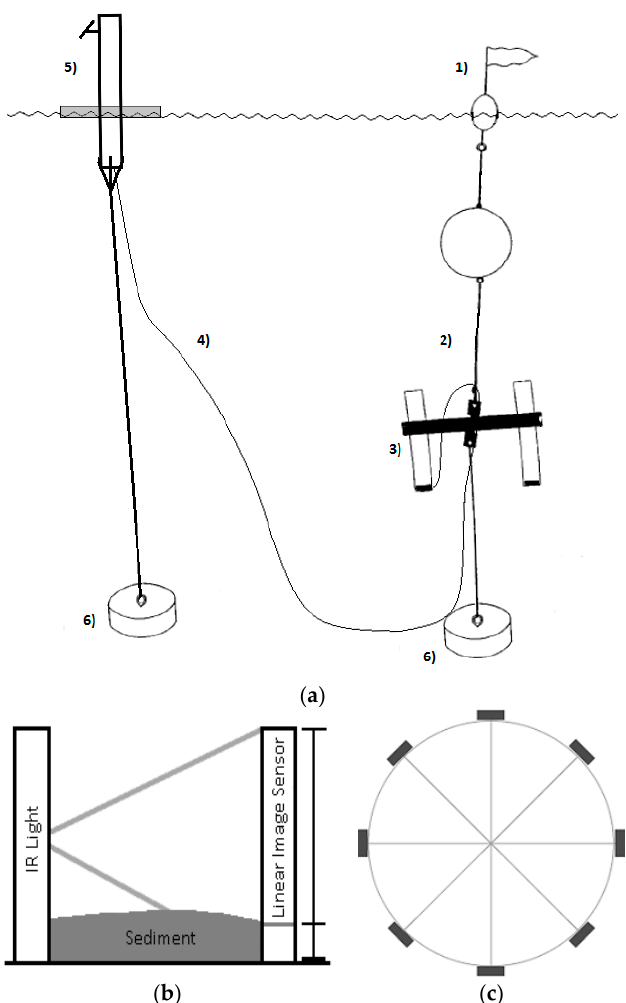
Figure 2. ( a ) Schematic illustration showing the online trap configuration: (1) signal buoy, (2) sediment trap, (3) trap collector tube with tomography device, (4) cable connecting tomography device with solar panel energy supply and Internet network, (5) float providing Internet connection and energy supply, and (6) anchors. ( b ) Cross-section illustration of tomographic scanning at the lower part of the modified trap collector tube, and ( c ) location of optical transmitters and receiver pairs at the bottom of the modified trap tube.